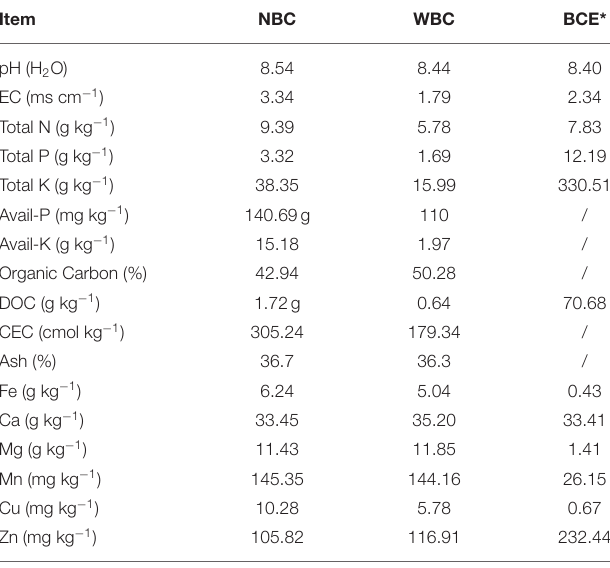
TABLE 1 | Properties of non-treated fresh biochar, washed biochar, and biochar extract.